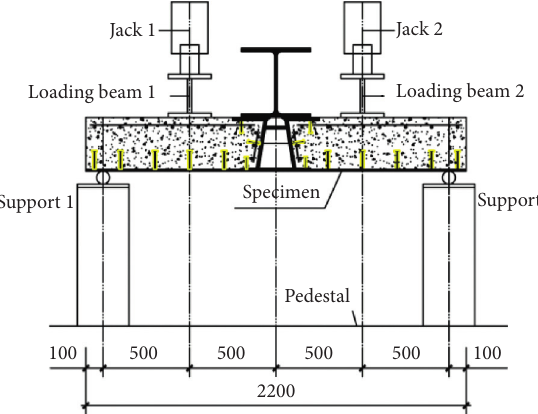
Figure 7: Loading diagram of the flexural experiment.